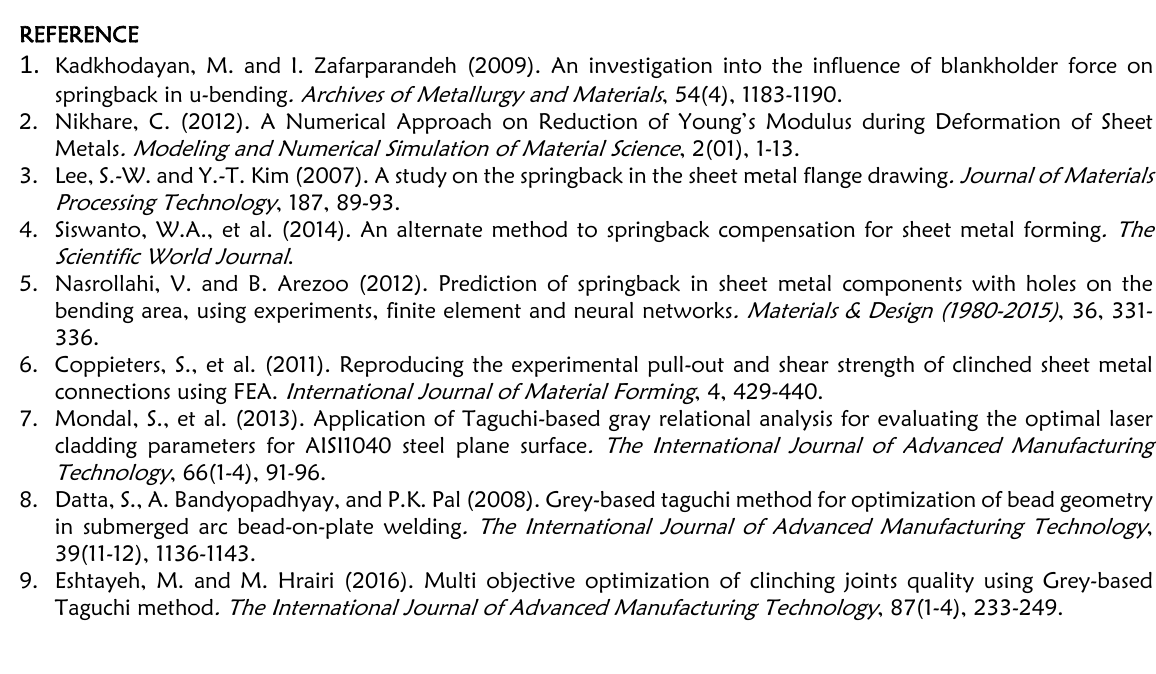
values (opening between the two sheets after forming the joints) between the two sheets. The optimization of the clinching process to indicate the optimal parameters affecting the springback between the two sheets can be obtained using the Taguchi optimization